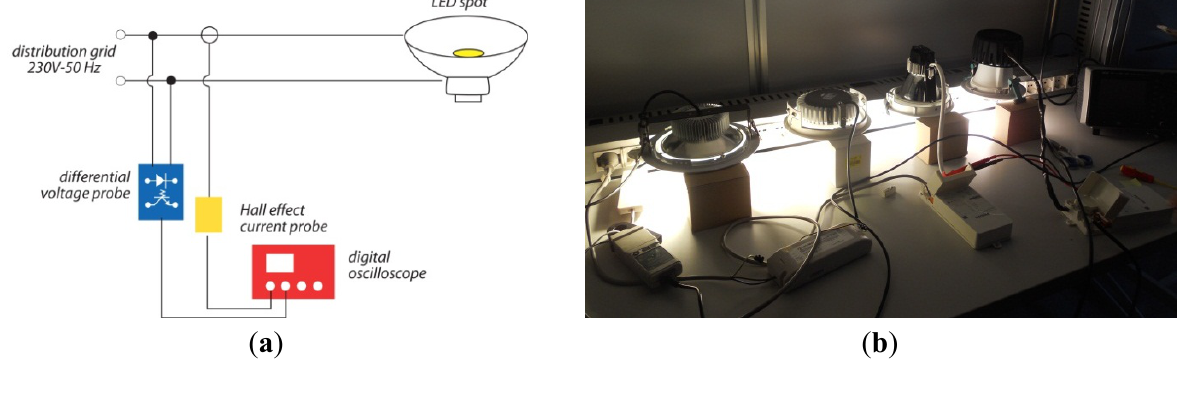
Table 3. Power quality analysis of the measurements results for LED